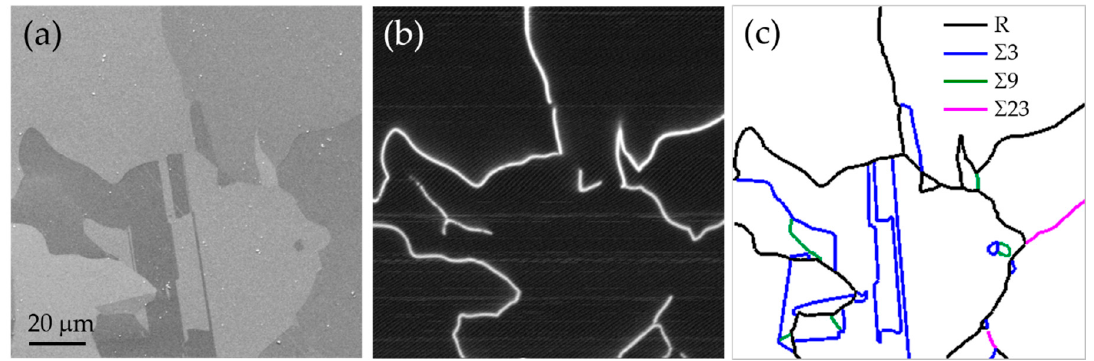
Figure 4. SE ( a ), EBIC ( b ), and electron back-scattered diffraction (EBSD) ( c ) images of bright GBs outside of Al Schottky contact. SE and EBIC images were taken at 7 kV.